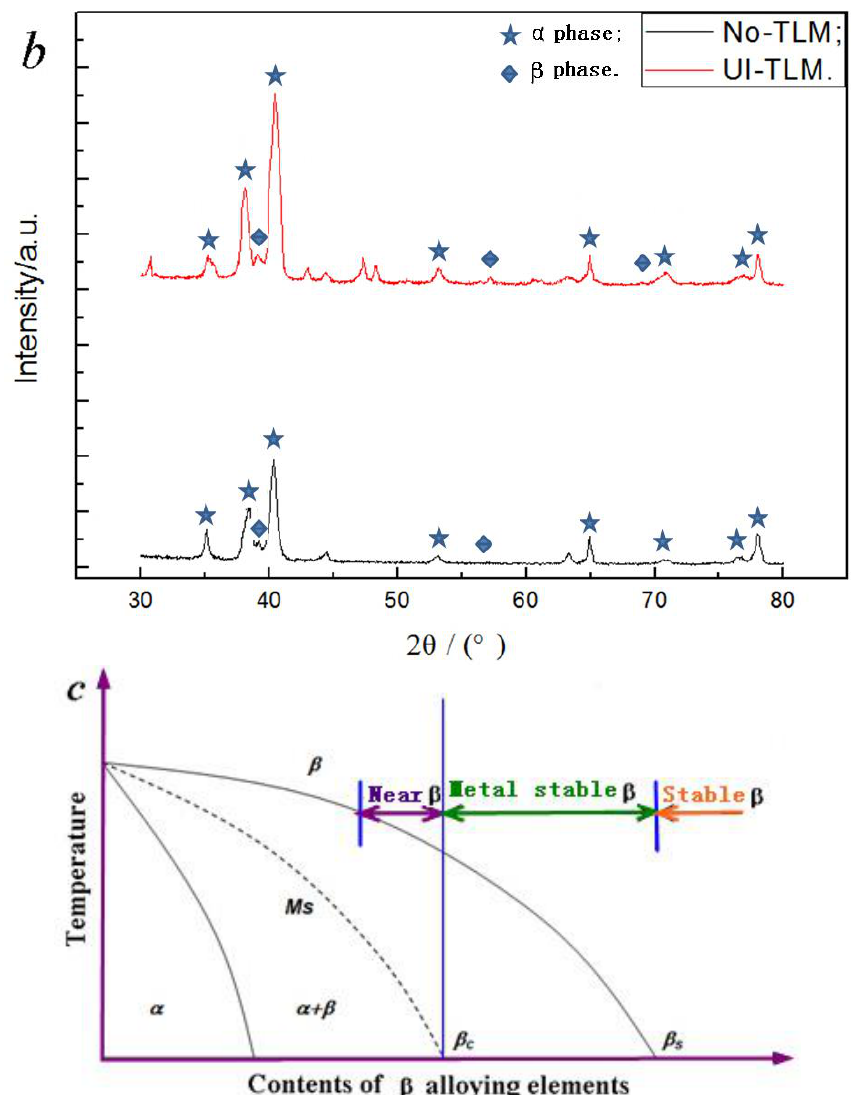
Figure 5. Analysis of XRD patterns: ( a ) TC4; ( b ) TLM; ( c ) pseudobinary phase diagram of β-type titanium alloy.